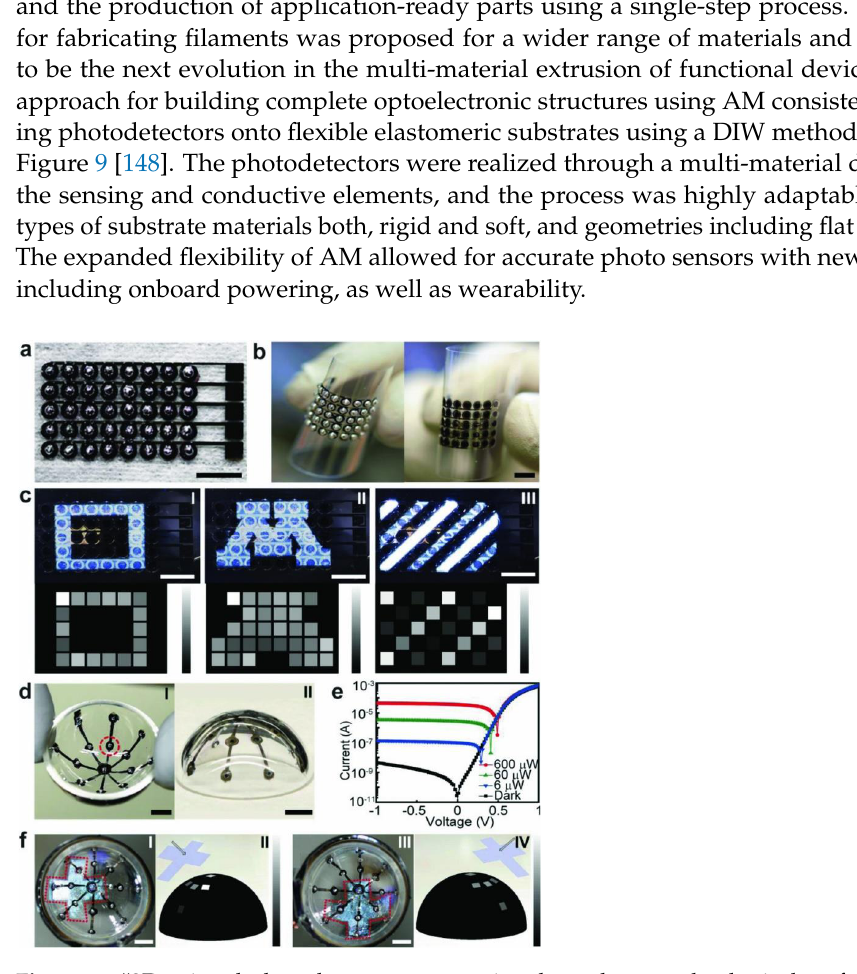
Figure 9. “ 3D-printed photodetector arrays printed on planar and spherical surfaces. ( a ) 5 × 8 photodetector array printed on PET. ( b ) Photographs of the bent photodetector array on PET films, viewed from both sides. ( c ) Characterization of the flexible photodetector array as an image sensor. Optical patterns projected onto the photodetector array and the reconstructed images: (I) square pattern; (II) letter “M;” and (III) white -light parallel strips with varying intensities. The range of the grayscale bars is from 0 (black) to 300 nA (white). ( d ) Photographs of the concentric photodetector array printed onto the inner surface of a hemispherical glass dome: (I) inside view and (II) outside view of the 3D-printed concentric photodetector array. ( e ) Current – voltage characteristics of the photodetector highlighted in ( d ). The excitation light source is a 405 nm laser of varying intensities. ( f ) Characterization of the spherical photodetector array as an image sensor. (I) the projected cross mark onto the devices (denoted by the dashed outline); (II) reconstructed cross mark pattern; (III and IV) cross mark pattern projected onto the spherical photodetector array rotated 90° and the reconstructed cross mark pattern. The range of the grayscale bar is from 0 (black) to 300 nA (white). Scale bars are 5 mm. ” [Park, S.H.; Su, R.; Jeong, J.; Guo, S.-Z.; Qiu, K.; Joung, D.; Meng, F.; McAlpine, M.C. 3D Printed Polymer Photodetectors. Adv. Mater. 2018, 30, 1803980, Copyright Wiley-VCH GmbH. Reproduced with permission].